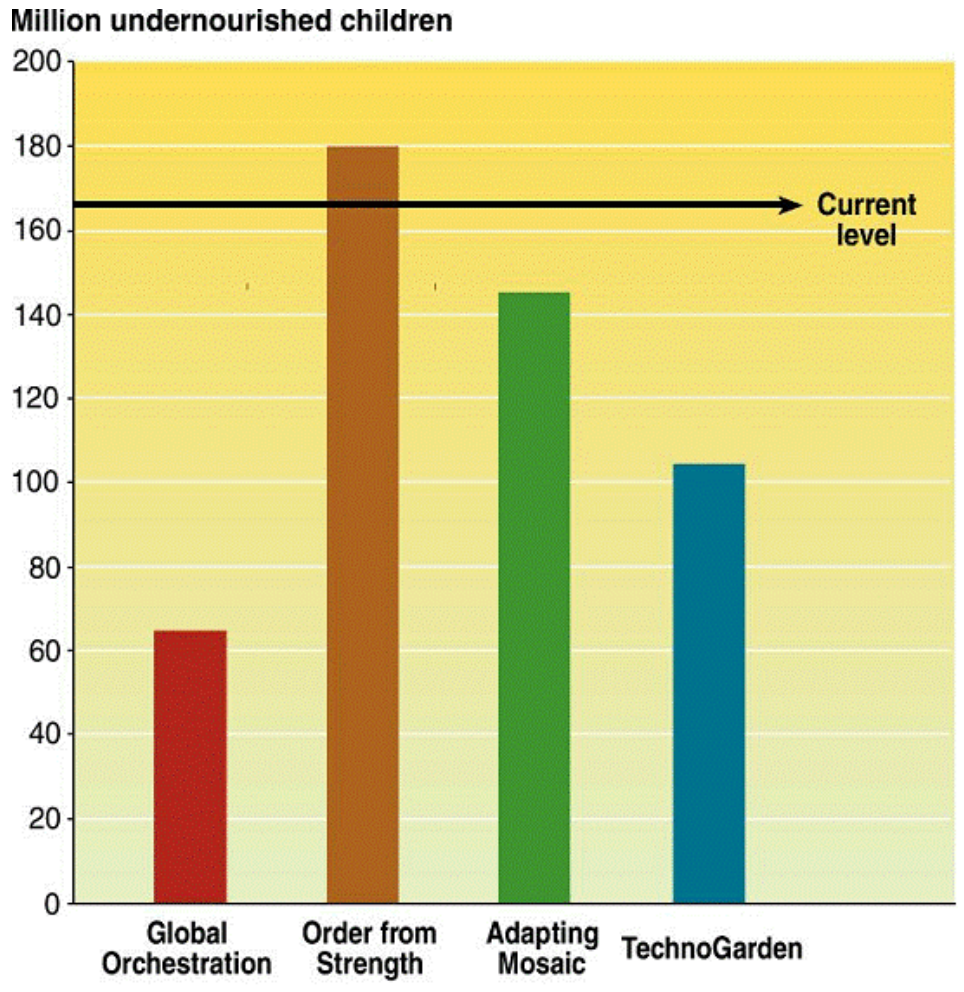
Fig. 2. The estimated number of undernourished children in 2050 compared with the present is shown in each scenario. This is lowest in Global Orchestration, but increases in Order from